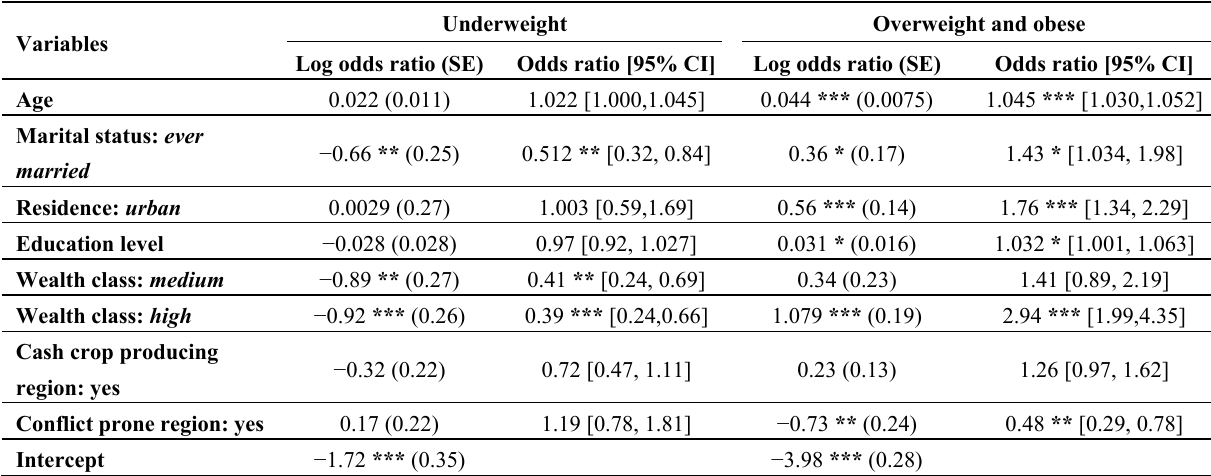
Table 3. Multinomial regression results for the association between socioeconomic and demographic risk factors and weight status of adult women in the sample ( N =